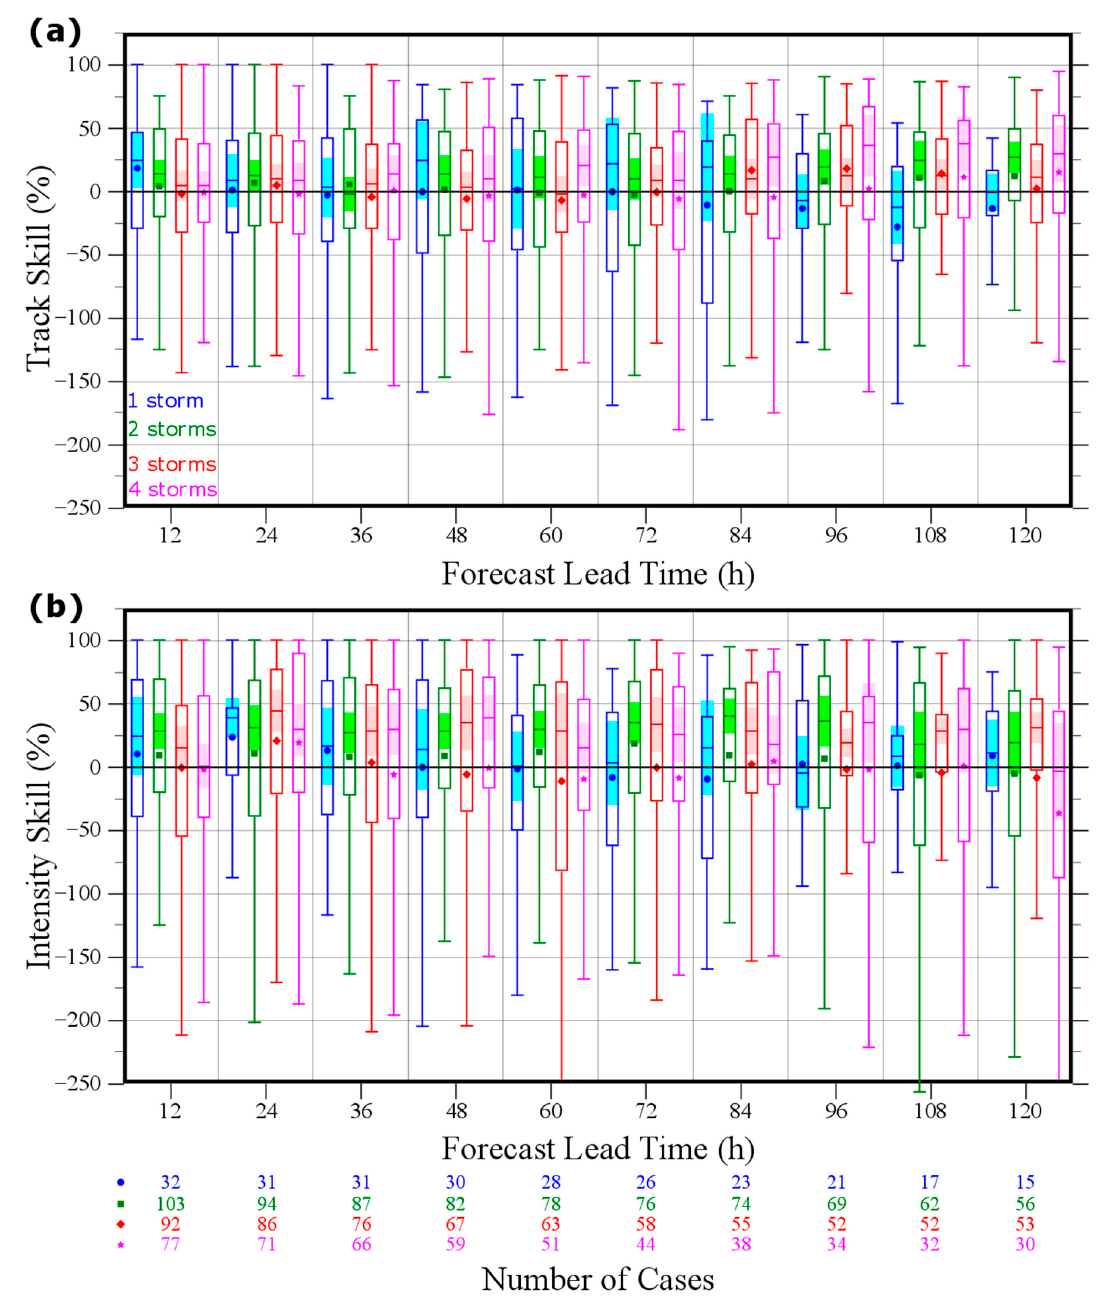
Figure 3. As in Figure 2, except forecast skill scores (Equation (1)) in the North Atlantic are stratified by the number of combined storms (i.e., TCs and invests) in the North Atlantic and eastern North Pacific at the forecast initialization time for: ( a ) track forecast skill and ( b ) intensity forecast skill. The following stratifications are shown for each forecast lead time: one active priority storm (blue; circle), two storms (green; square), three storms (red; diamond), and four storms (pink; star). The number of cases for each stratification and each forecast lead time are provided at the bottom.